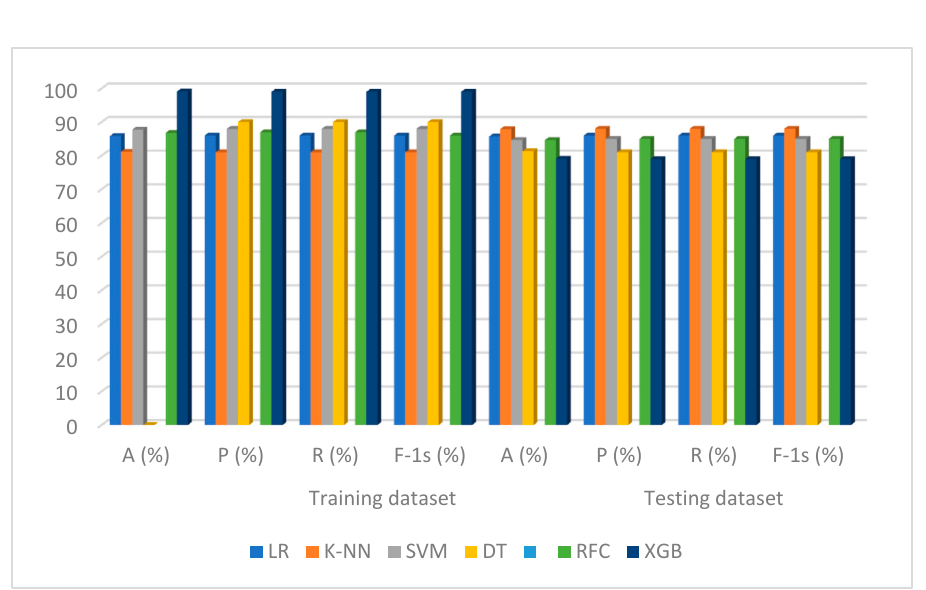
Figure 7. The performance evaluation of the suggested system in graphical form. Table 6. The classification report of models using the training and testing datasets compared with a hyperparameter tuning